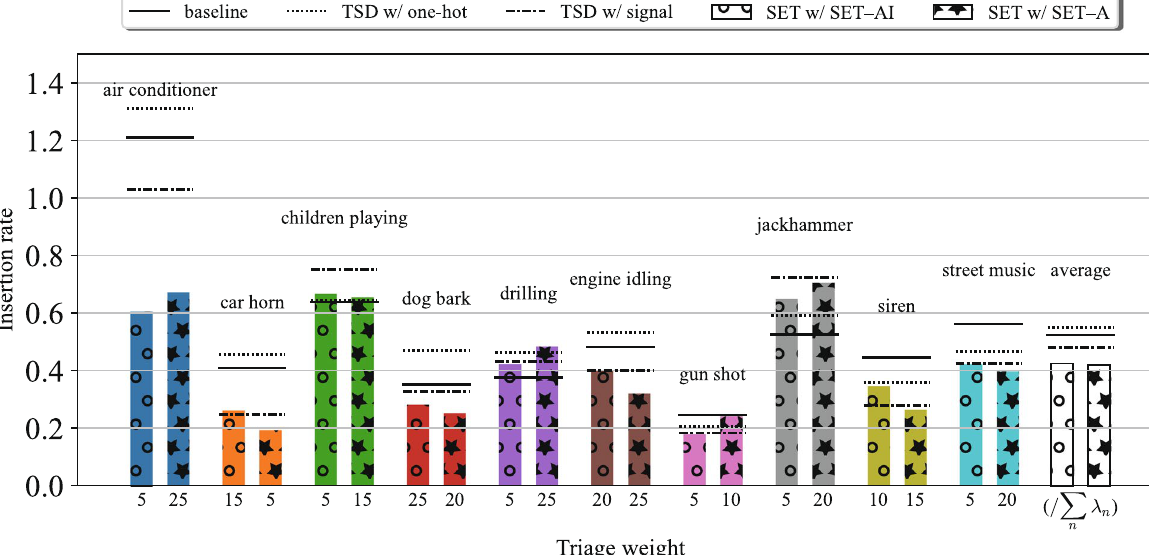
Fig. 8 SET results in terms of insertion rate for target classes